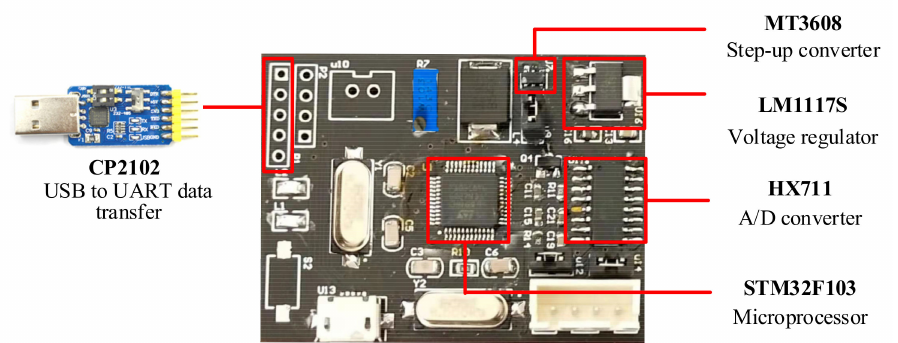
Figure 3. Circuit board integrated with the weight data acquisition part. The voltage level of the hardware platform is 5 V and the regulator chooses the low dropout regulator (LDO) LM1117. USB to UART data transfer is a modular structure, inserted into the circuit board.